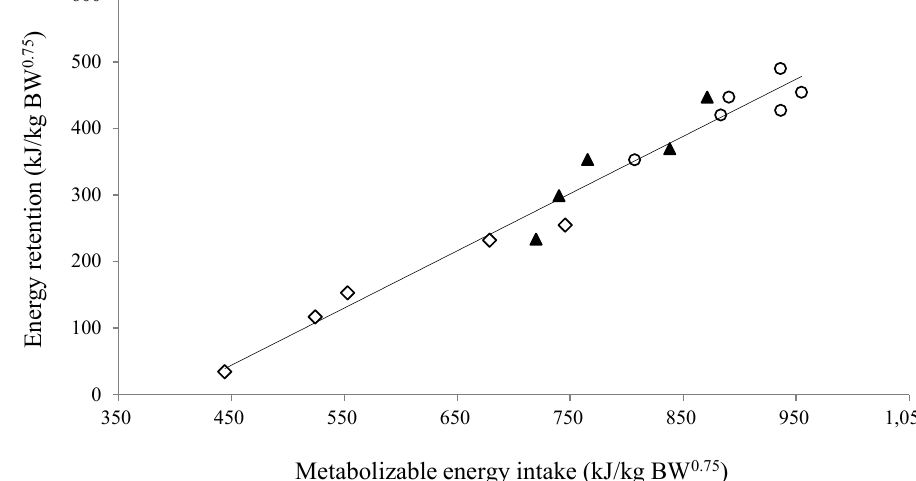
Figure 1. Linear regression of energy retention (ER, kJ/kg BW 0.75 ) against metabolizable energy intake (MEI, kJ/kg BW 0.75 ) of yearling Thai native beef cattle fed fermented total mixed ration diets with different proportions [100 (◊), 300 ( ▲ ), and 500 ( ○ ) g/kg dry matter basis] of cassava pulp instead of rice straw. Equation: ER = (0.860 (SE=0.05) ×MEI) – 342.7 (SE=35.96) ( r 2 = 0.96; p<0.001; residual standard deviation = 6.9).